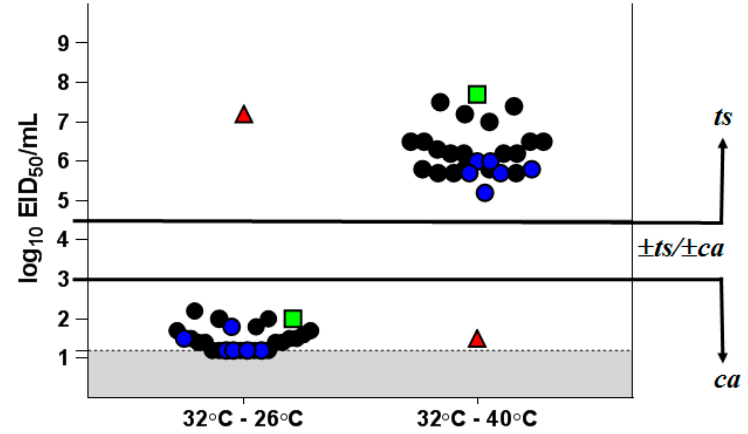
Figure 1. Growth restriction of H7N9 LAIV clinical isolates at different temperatures. The results are expressed as the reduction in virus titer at 40 °C or 26 °C from the titer at the optimum temperature of 32 °C. Black circles—isolates obtained after the first vaccine dose; blue circles—isolates obtained after the second vaccine dose; red triangle—H7N9 WT virus; green square—H7N9 LAIV candidate; gray—the limit of virus detection (1.2 log 10 EID 50 /mL).